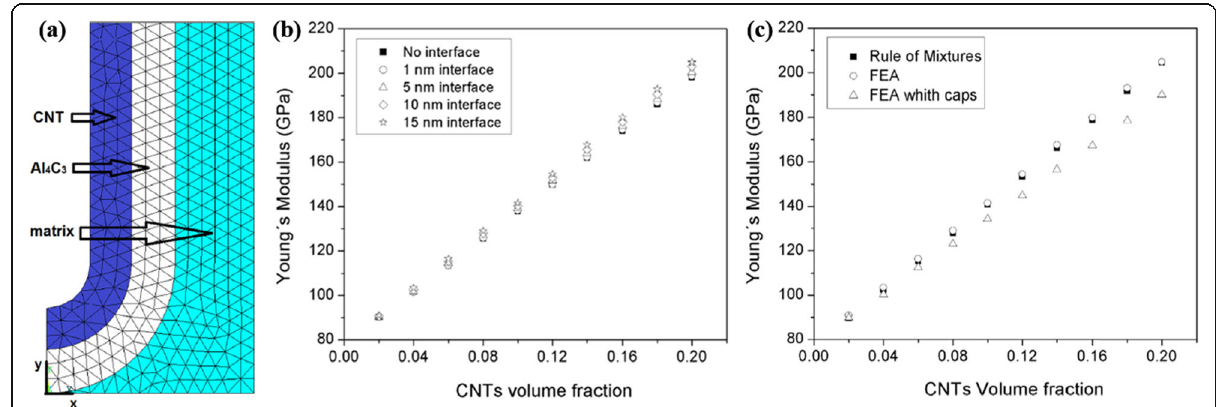
Fig. 2 ( a ) Axi-symmetric meshing for the MMC reinforced with 0.20 volume fraction of CNT and interfaces of 15nm with end-cap, ( b ) Young ’ s moduli variation vs CNT volume fraction, depending on the thickness of the interfacial Al 4 C 3 layer for estimations obtained using FEA, and ( c ) Young ’ s moduli variation vs CNT volume fraction, for estimations obtained using Rule of Mixtures and FEA models, and interfacial Al 4 C 3 layer thickness of the 15nm (Alfonso et al. 2015). Reprinted from Alfonso et al. (2015) ( Compos. Struct. 127, 420 – 425) with Composite Structures ’ s